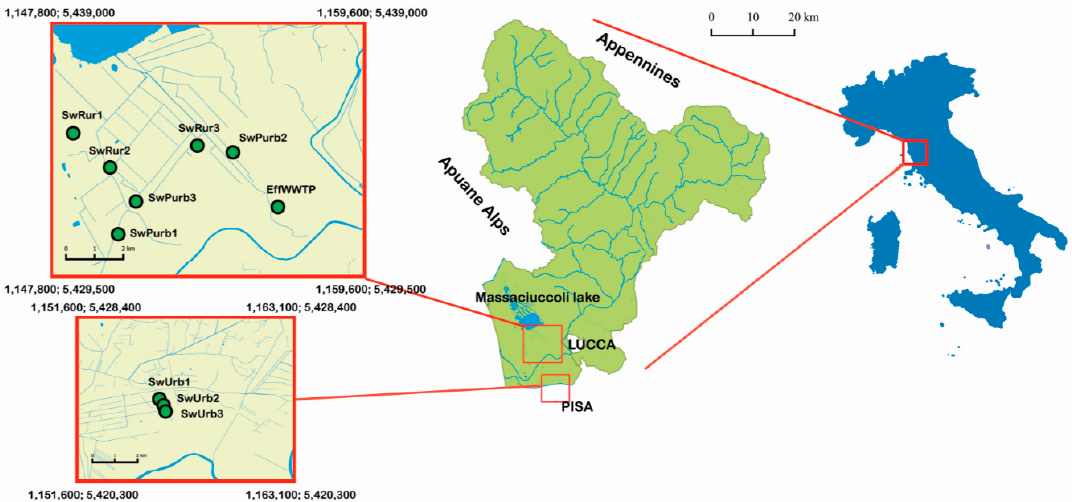
Figure 1. Map of the study area and sampling points of the March and September campaigns in a coastal area of Central Italy. Sampling points are a rural area (SwRur), a periurban area (SwPurb), an urban area (SwUrb), and the effluent of a wastewater treatment plant (EffWWTP).